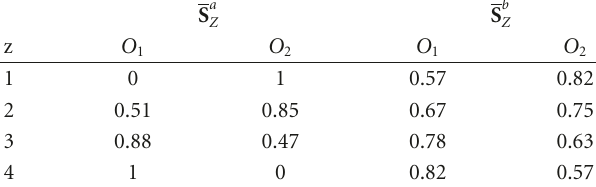
and S b for which L = 2 Z Z